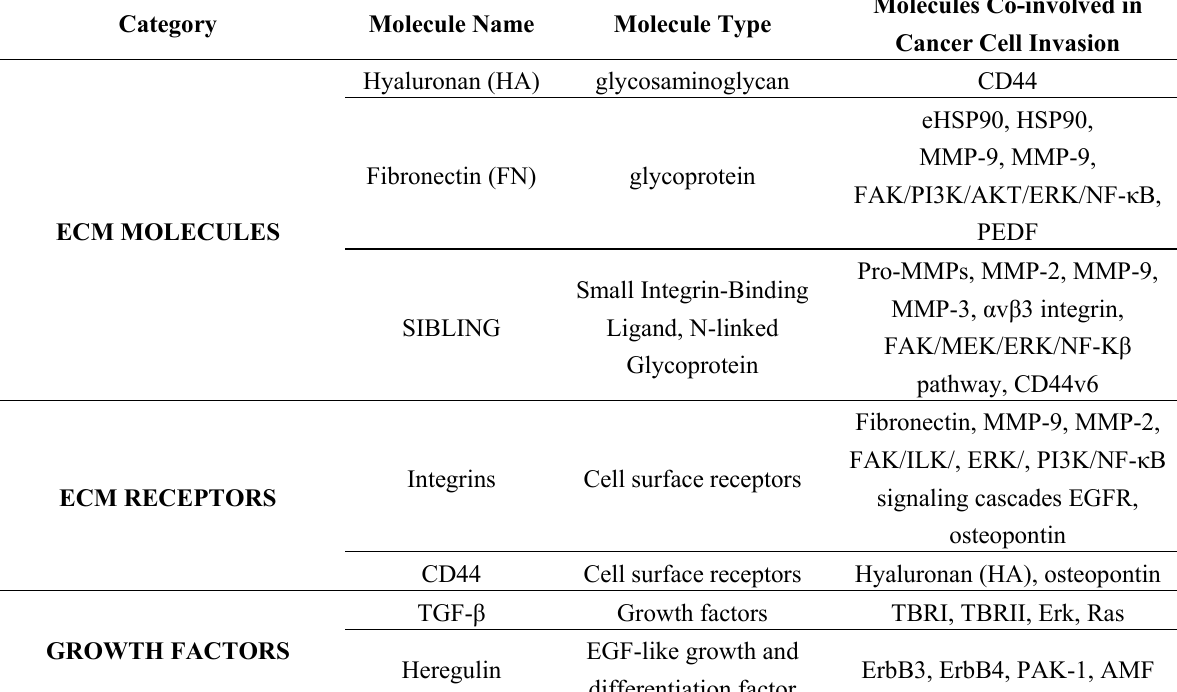
Table 1. Extracellular molecules involved in cancer cell